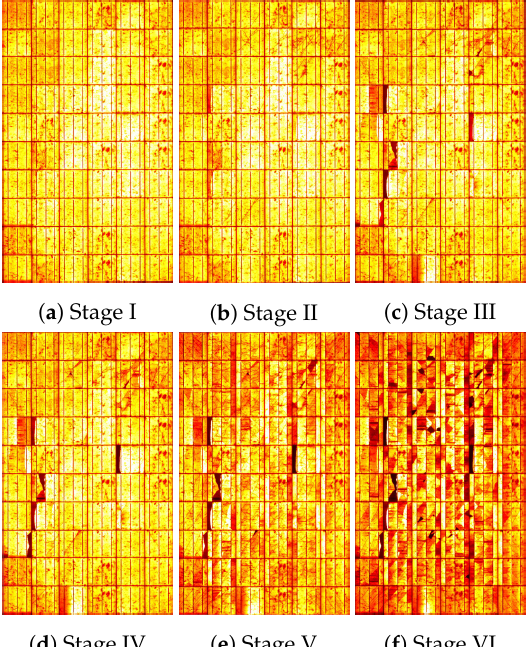
Figure A1. EL images of module #2, measured at STC I sc current bias, before the accelerated stress test (Stage I), and after each stress stage described in Table 1. Brighter image areas correspond to cell regions with higher luminescence, whereas darker areas correspond to low or no luminescence emissions.